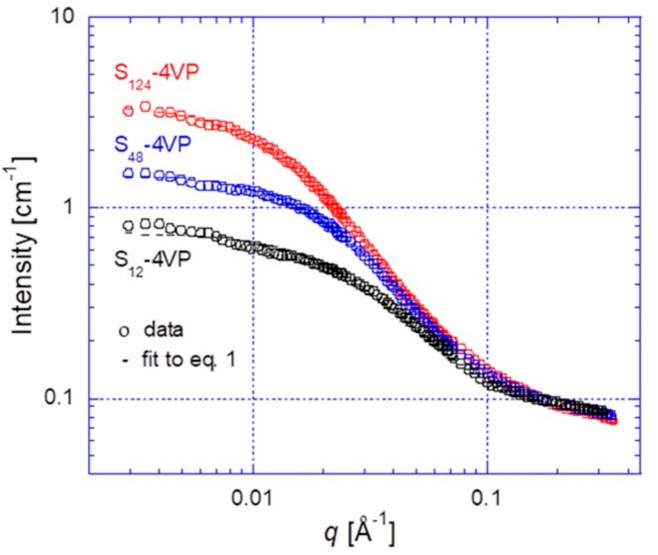
Figure 4. SANS patterns from 1 wt.% solution of the S4VP block copolymers of varying PS block molecular weights, 12, 48, 124 kDa, with their fit to Equation